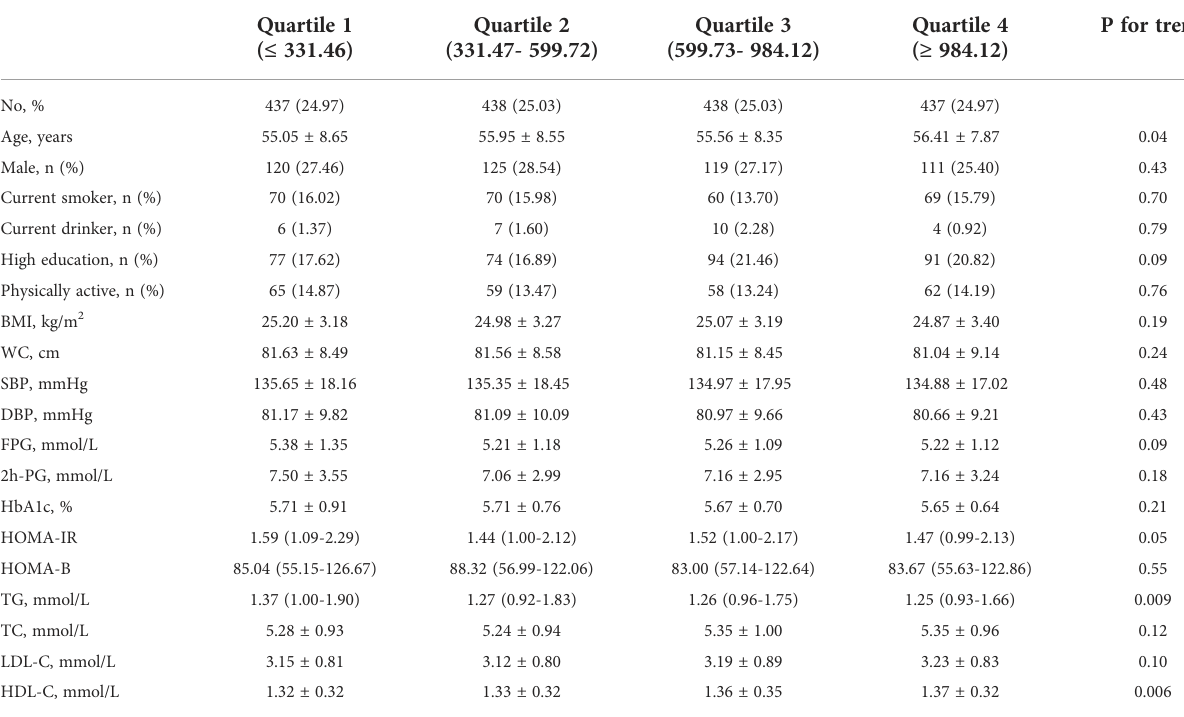
TABLE 1 Baseline characteristics according to the quartiles of serum